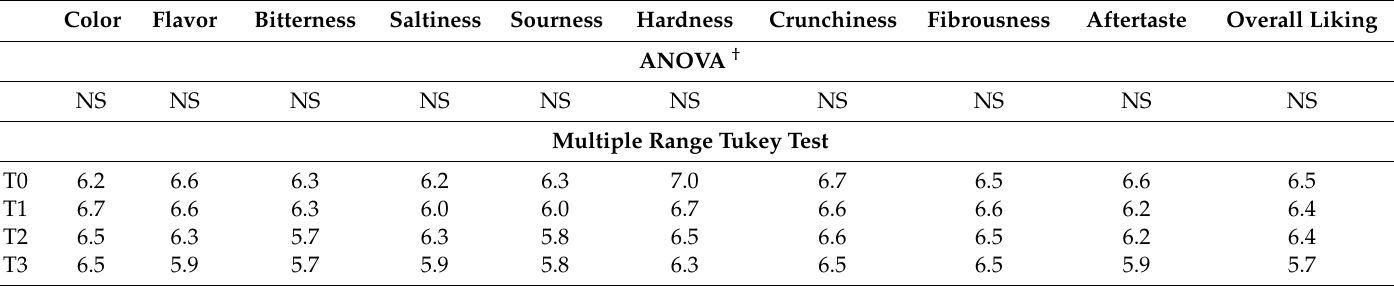
Table 4. A ff ective sensory analysis (at 3 locations in Spain) of table olives as a ff ected by irrigation treatment. Color Flavor Bitterness Saltiness Sourness Hardness Crunchiness